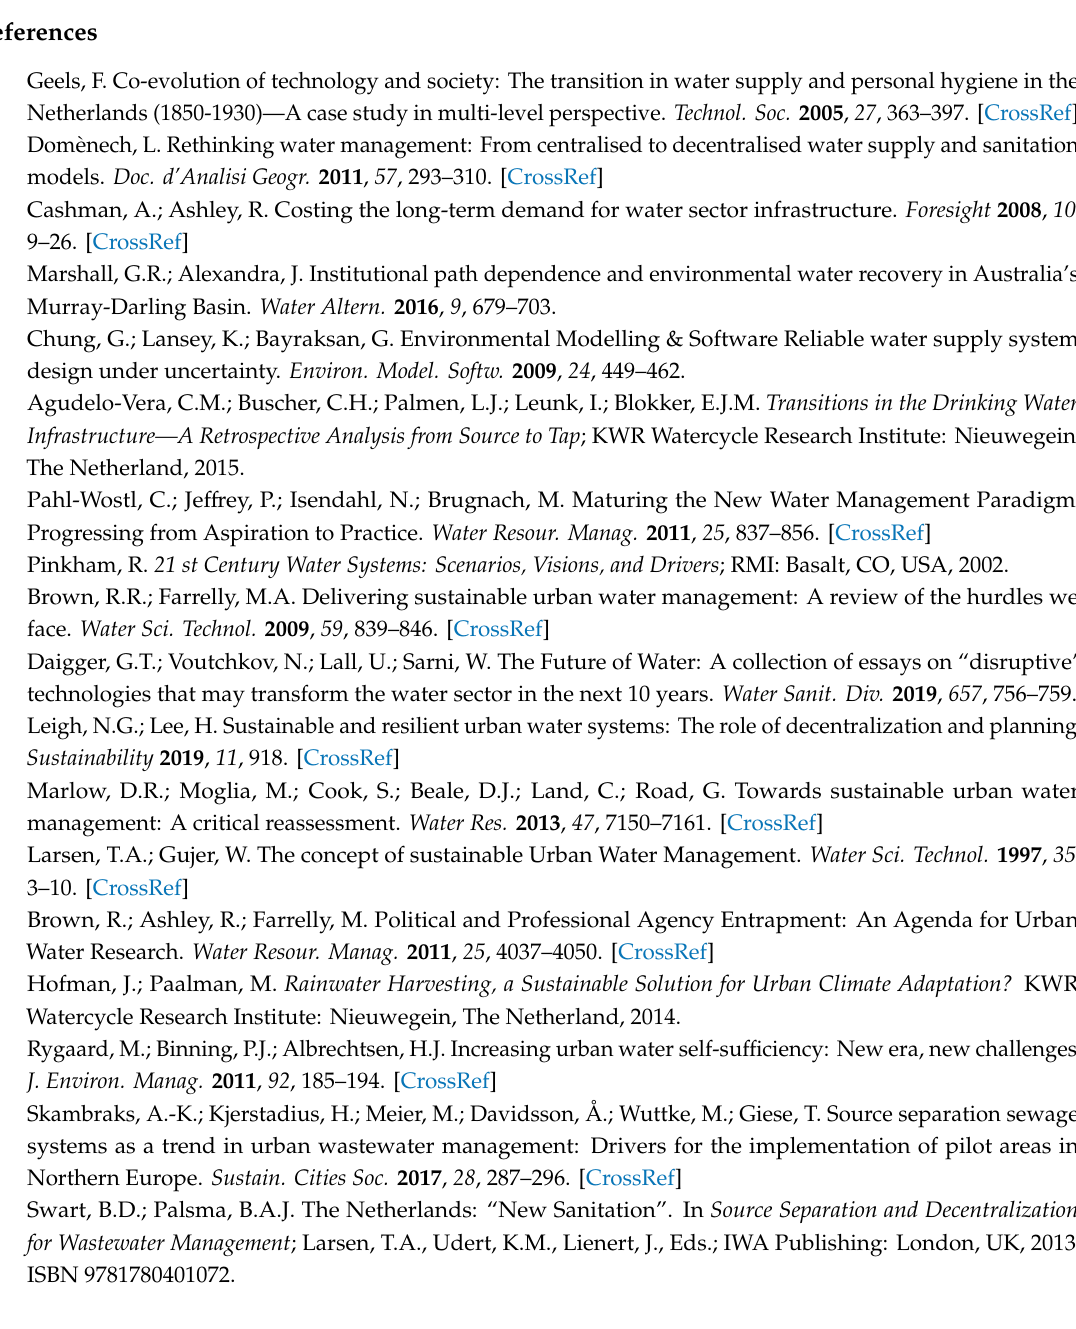
Table A3. Quantitative input data for individual water demands (STEP